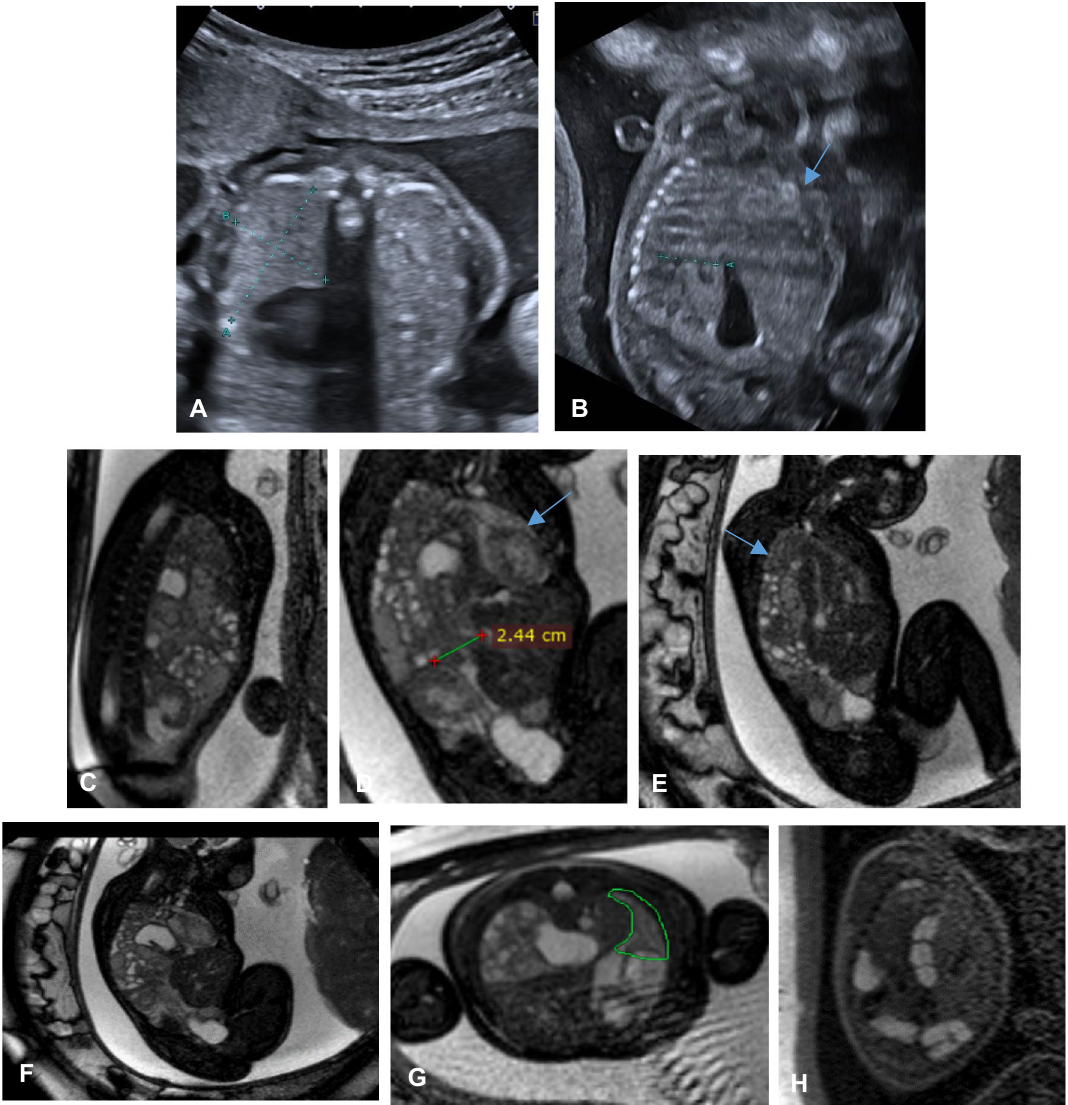
Fig. 6 A 39-year-old pregnant female with antenatal US showing large congenital diaphragmatic hernia. Ultrasound findings: A, B Axial and coronal sections of the fetal abdomen and chest showing left diaphragmatic hernia with herniation of the stomach and bowel into chest. MRI Findings: C, D, E sagittal T2WI, B coronal T2WI, and E axial T2WIs showing a large left-sided rather posterior diaphragmatic defect with herniation of the whole stomach, small bowel loops, and left hepatic lobe into whole left hemithorax with consequently marked compression of the left lung, shift and compression of heart to the left side with compressed right lung (arrowed). F sagittal TWI showing high meconium signal within herniated colon into the left hemithorax. Combined US and MRI Diagnosis: Large left-sided intra-pleural hernia with marked mass effect on both lungs and heart with concluded poor postnatal survival rates. Termination by C.S at GA 37